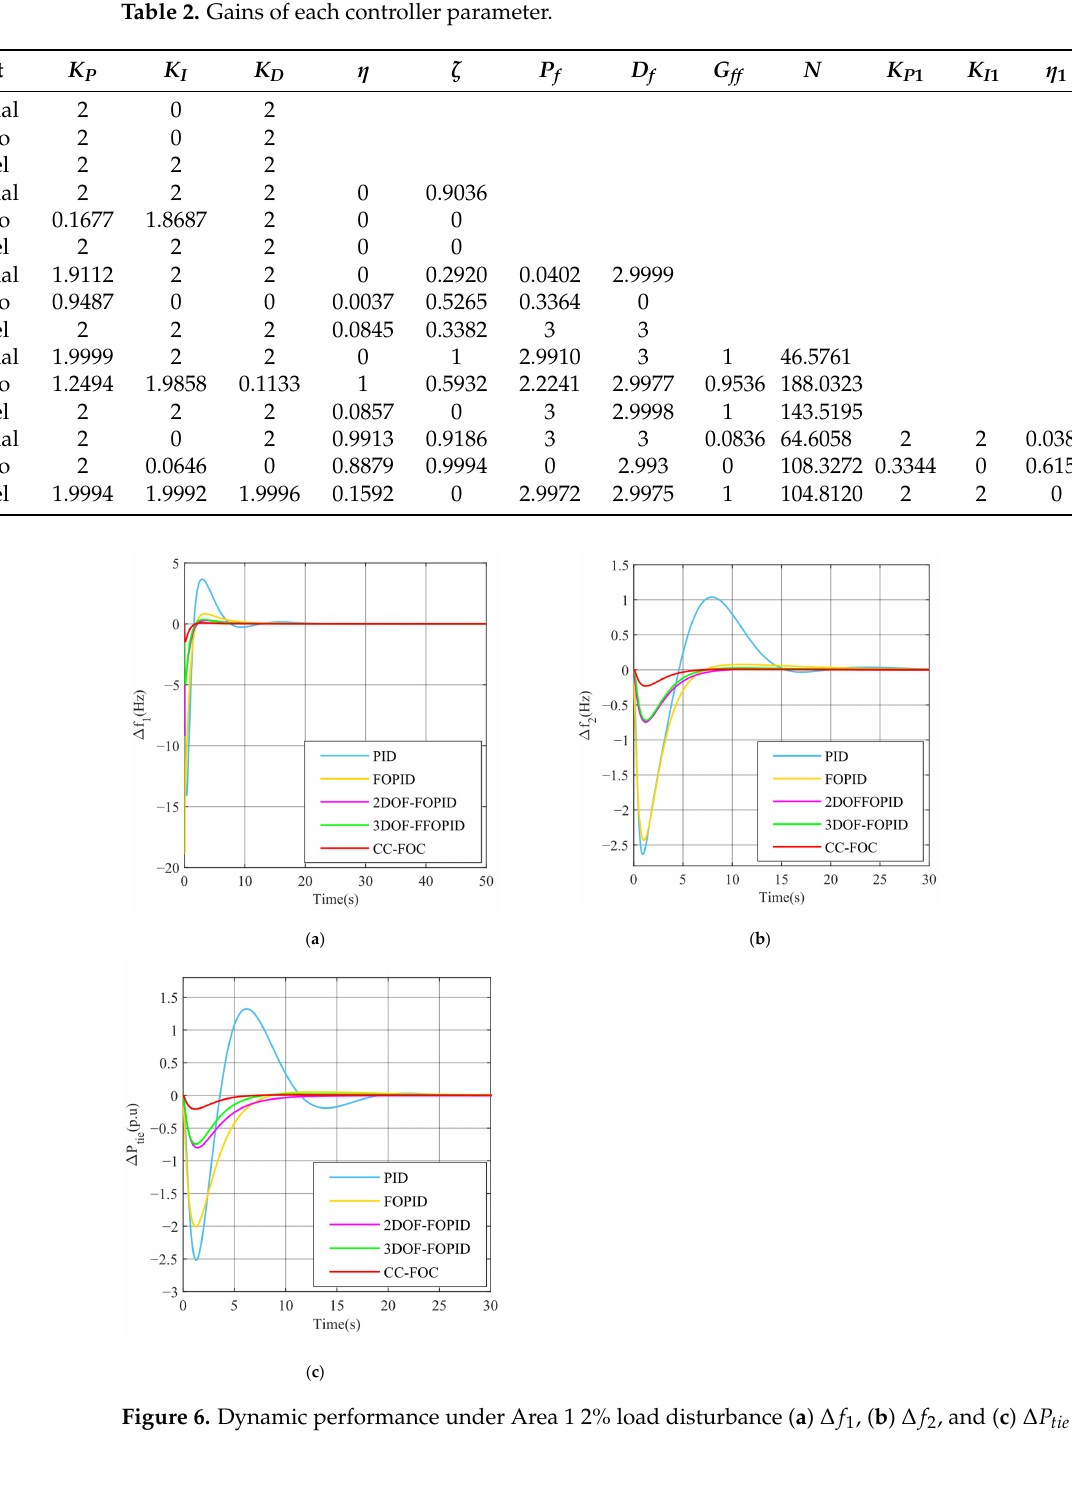
Figure 6. Dynamic performance under Area 1 2% load disturbance ( a ) ∆ f 1 , ( b ) ∆ f 2 , and ( c ) ∆ P tie